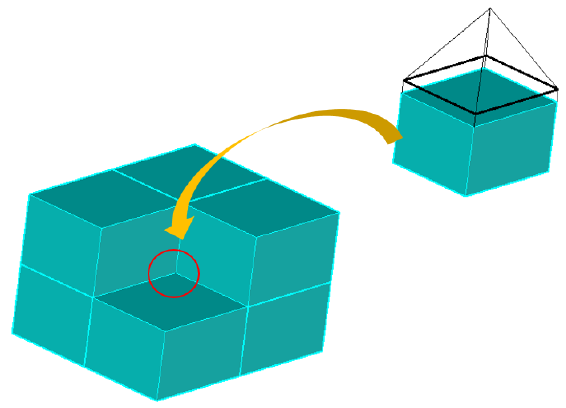
Figure 1. Di ffi culties in the last module Figure 1. Difficulties in the last module installation.